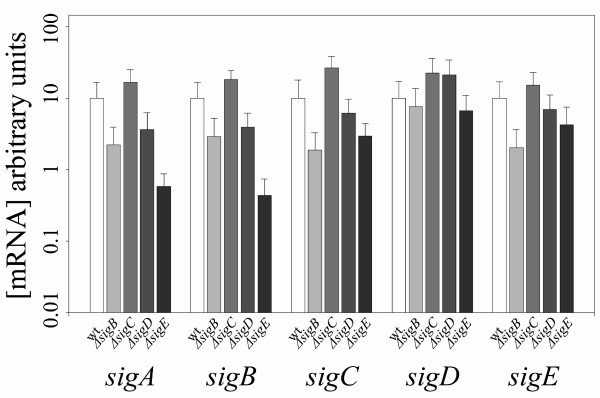
Transcription of sig genes in sigma mutants. sigABCDE genes were quantified in the wild type and the four sigma mutants (sigB, sigC, sigD and sigE). The gene quantified is indicated below each set of measurements. Within each set, the phenotype is indicated below each bar of the graph. All measurements were carried out under identical culture conditions for the wt and mutants strains. Values were normalized to the rpoA transcript. The expression of each gene in the wt strain was set equal to 10 (in arbitrary units). The reported values represent the average of 6 measurements obtained from two separate RNA preparations.